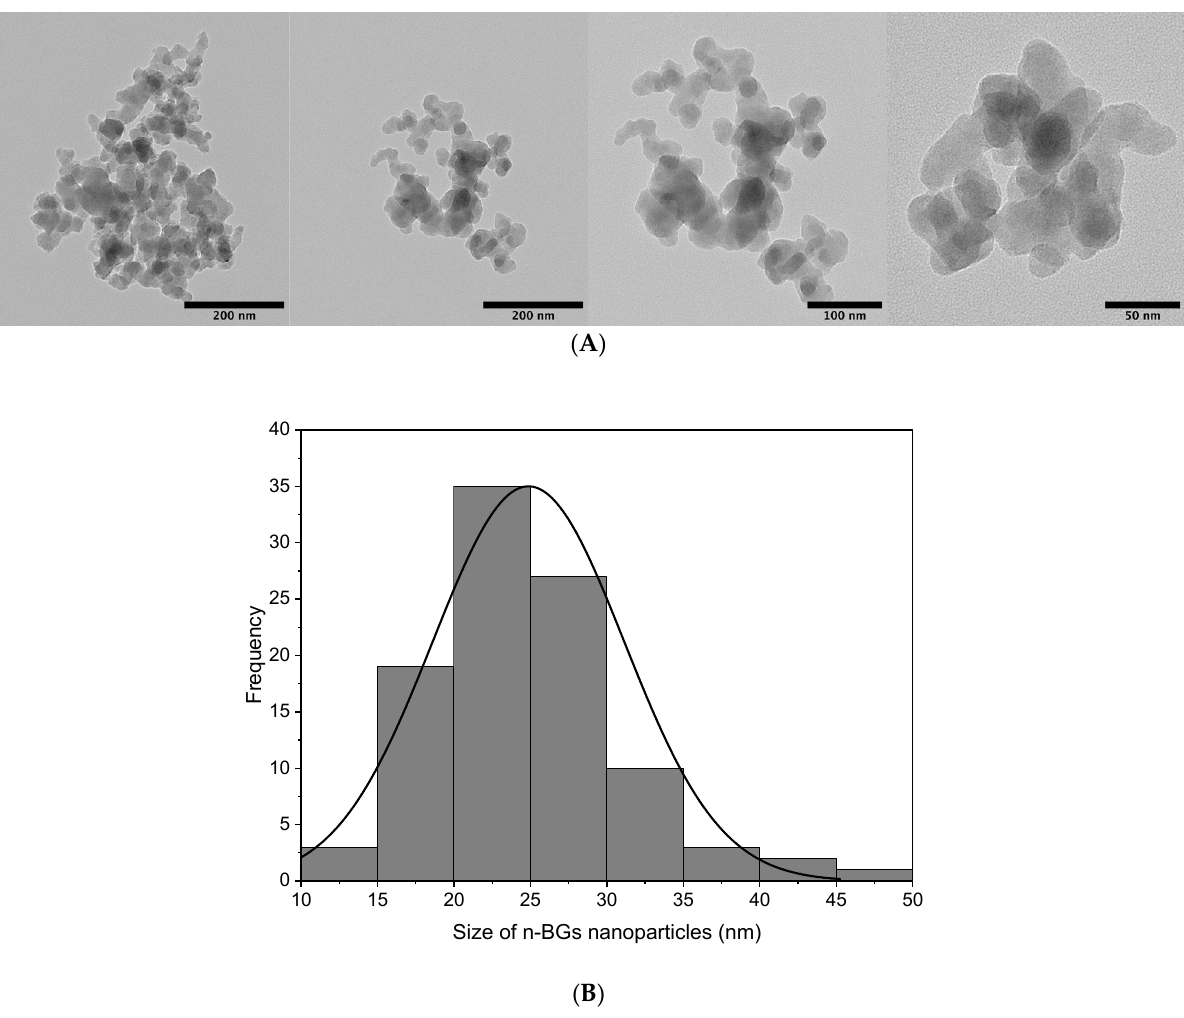
Figure 4. ( A ) TEM images of the n-BGs at 50, 100, and 200 nm and ( B ) histogram of the n-BGs.